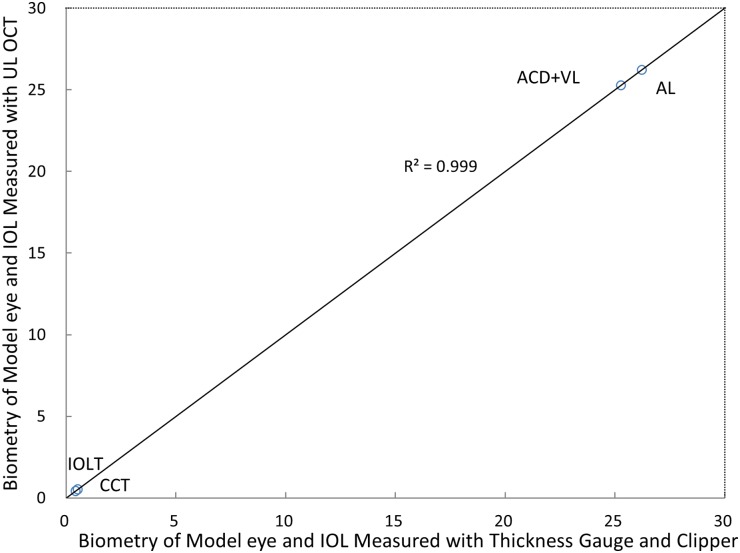
Graph shows the correlation between the axial biometry of the whole eye measured by CMOS-OCT and the actual geometry of the model eye combining an IOL.The solid line represented the equality. The correlation was strong (R2 = 0.999; P < .05). CCT = central corneal thickness; IOLT = IOL thickness; ACD = anterior chamber depth; VL = vitreous length; AL = axial length.